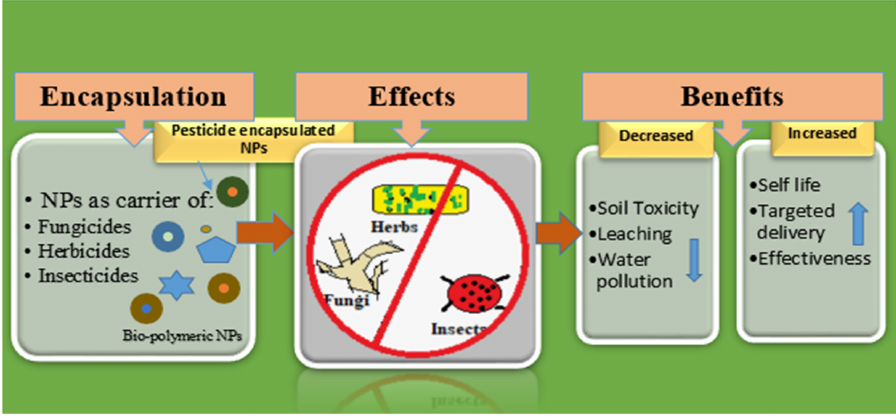
Figure 1. Biopolymeric NPs as carriers of herbicides, fungicides, and insecticides and their bene- fits.